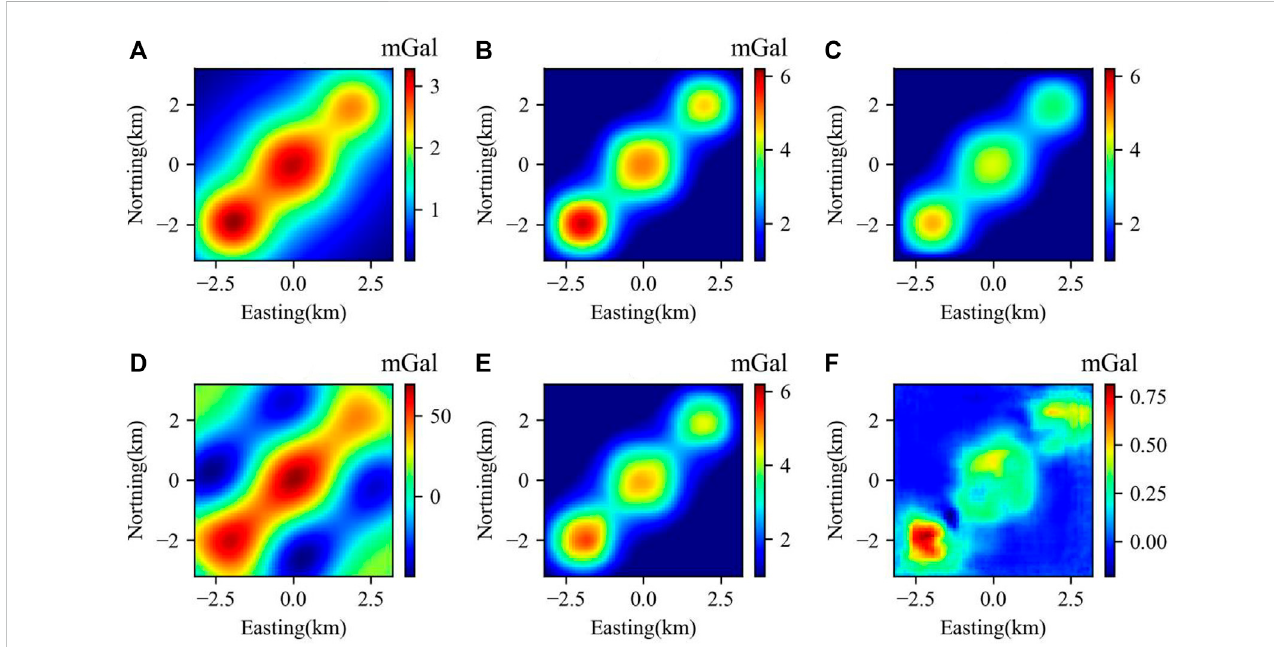
FIGURE 5 DCresultsfordifferentmethods: (A) gravityanomalyat500 m; (B) truevalueofthegravityanomalyat0 m; (C) DCgravityanomalyat0 musingtheTEDC method; (D) DC gravity anomaly at 0 m using the DFDC method with a fi lter equal to 1000; (E) DC gravity anomaly at 0 m using the DC-Net model; (F) error between (B) and (E) .